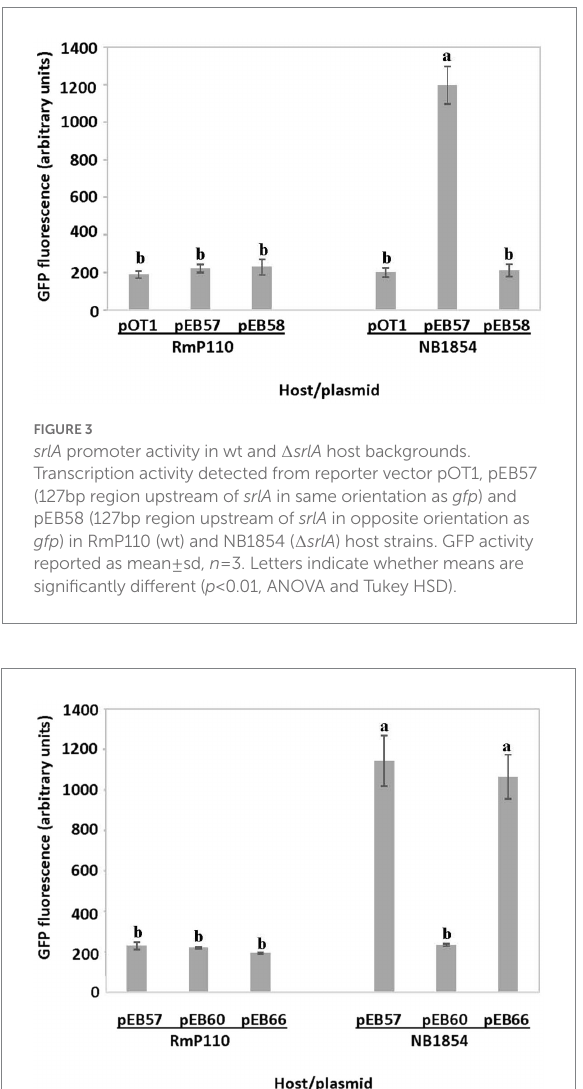
FIGURE 4 in cis repression of srlA promoter activity. Transcription activity detected from pEB57 ( srlA promoter- gfp fusion) and pEB60 ( srlA promoter- srlA ORF- gfp fusion) in RmP110 (wt) and NB1854 ( ∆ srlA ) host strains. pEB66 is a pEB60 derivative carrying an in- frame deletion in the srlA ORF. GFP activity reported as mean ± sd, n = 3. Letters indicate whether means are significantly different ( p < 0.01, ANOVA and Tukey